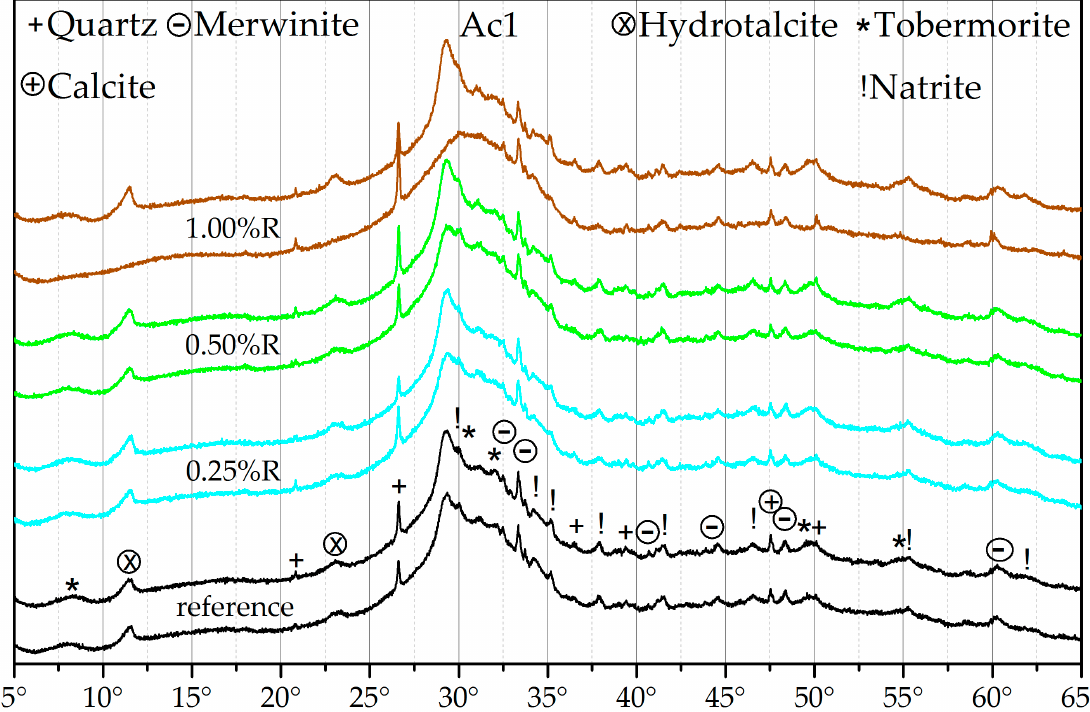
Figure 5. X-ray diffractogram of the reference of Ac1 (without retarder) and the reactivated mixtures with Ac1 after seven days of hydration of 0.25%, 0.50%, and 1.00%R—after hydration periods of seven (lower curve) and 28 days (upper curve) per test, with an angular range of 2 θ .